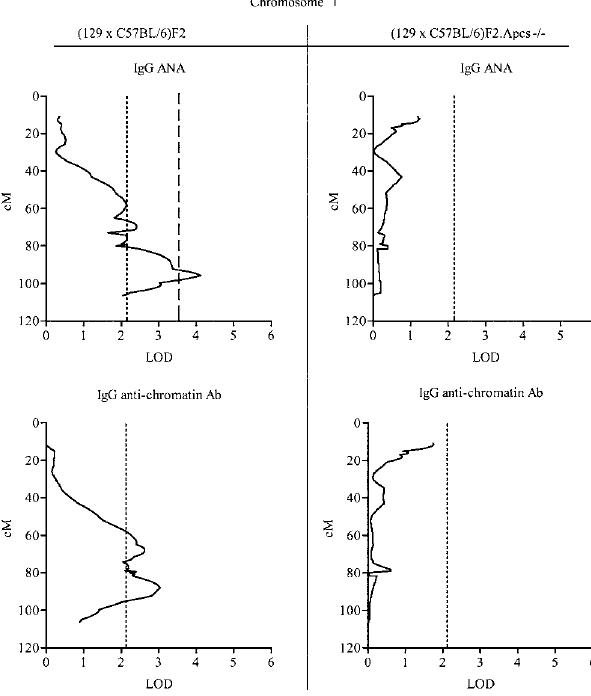
Figure 5. Interval Mapping Scans Showing QTL on Chromosome 1 with ANA and Anti-Chromatin Abs Centimorgan positions were deduced by interval mapping, anchoring marker locations to data from http://www.informatics.jax.org. Dotted lines indicate the threshold over which linkage was considered suggestive, and dashed lines indicate the threshold over which linkage was considered significant, as defined in Materials and Methods. See Table 3 for additional details. DOI: